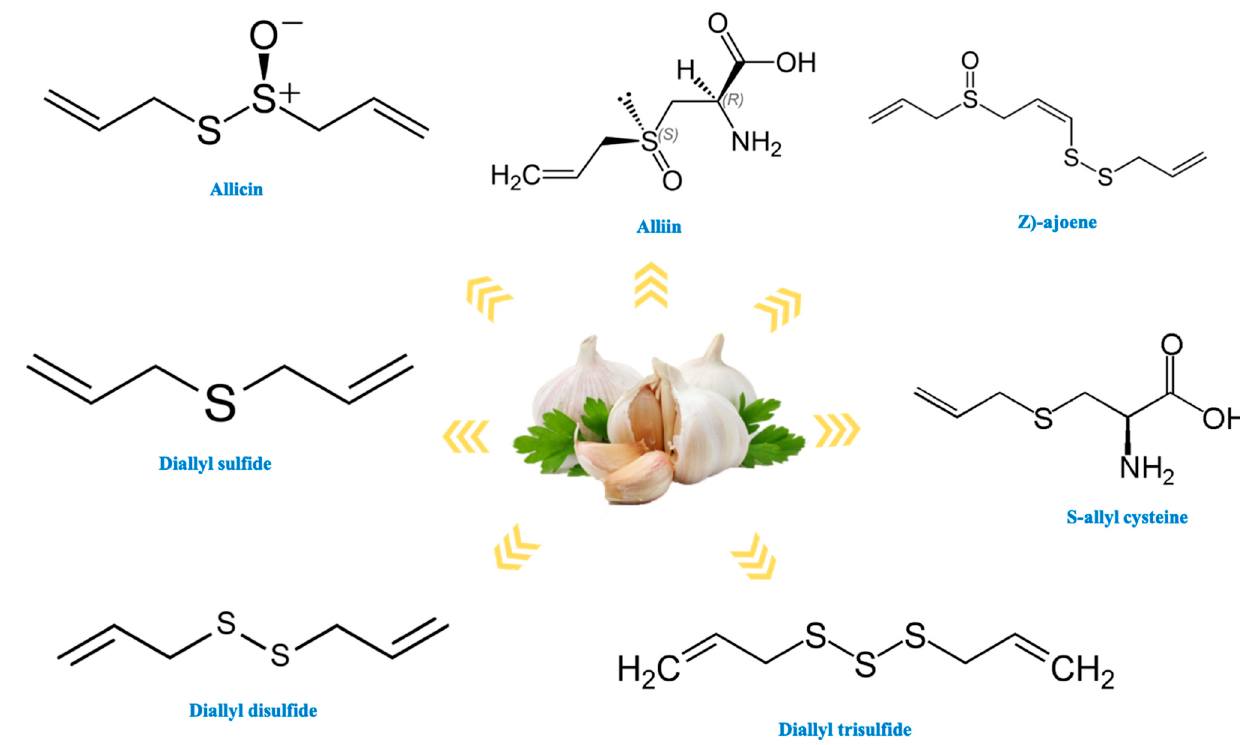
Figure 3. Structure of important bioactive constituents present in garlic.